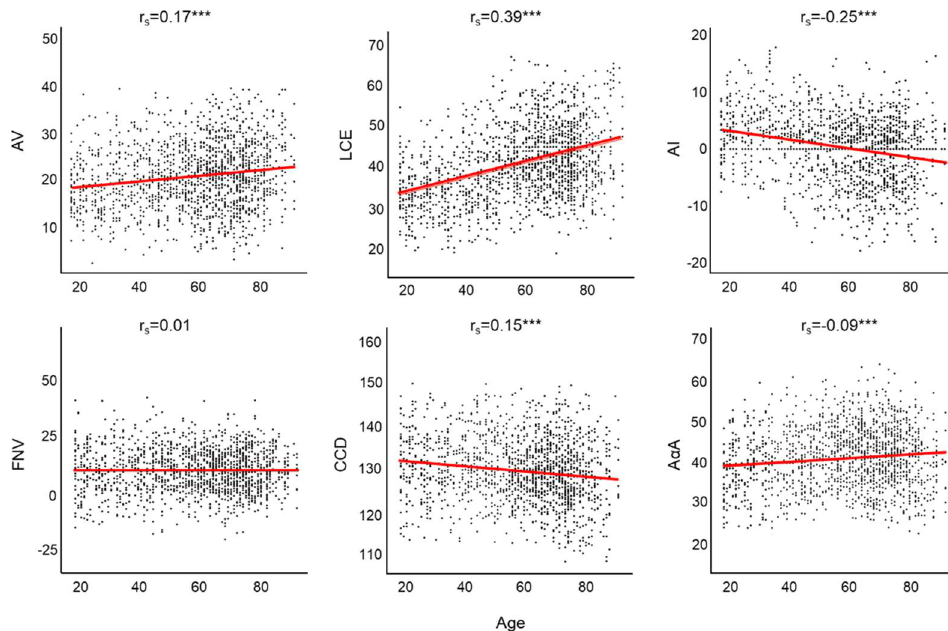
Scatterplot—Correlation analysis between morphological parameters of the